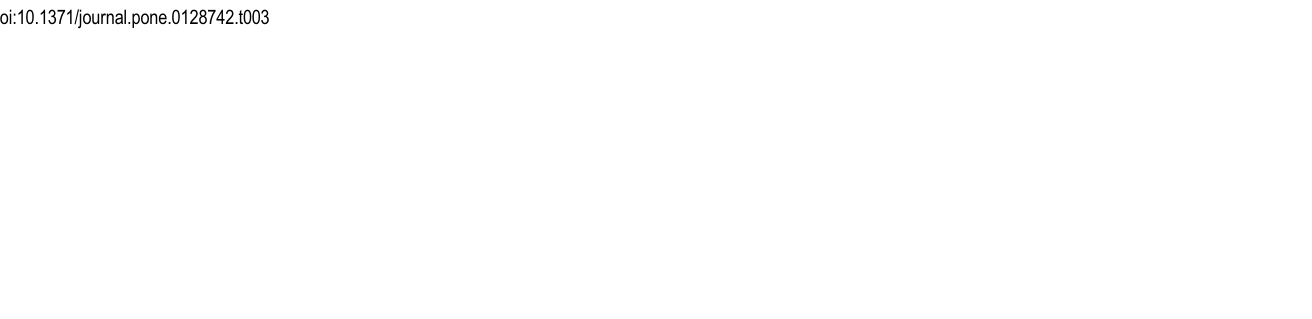
Best ten BLASTP hits against the NCBI nr database for each of the proteins from Mnemiopsis . Numbers indicate e-values, for which a cutoff of 1e-3 was used. MLRB263549 was truncated and therefore did not align to many